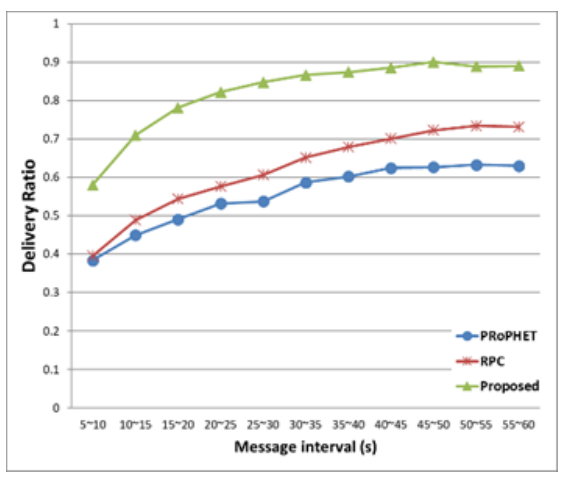
Figure 8. Delivery ratio for different message intervals.